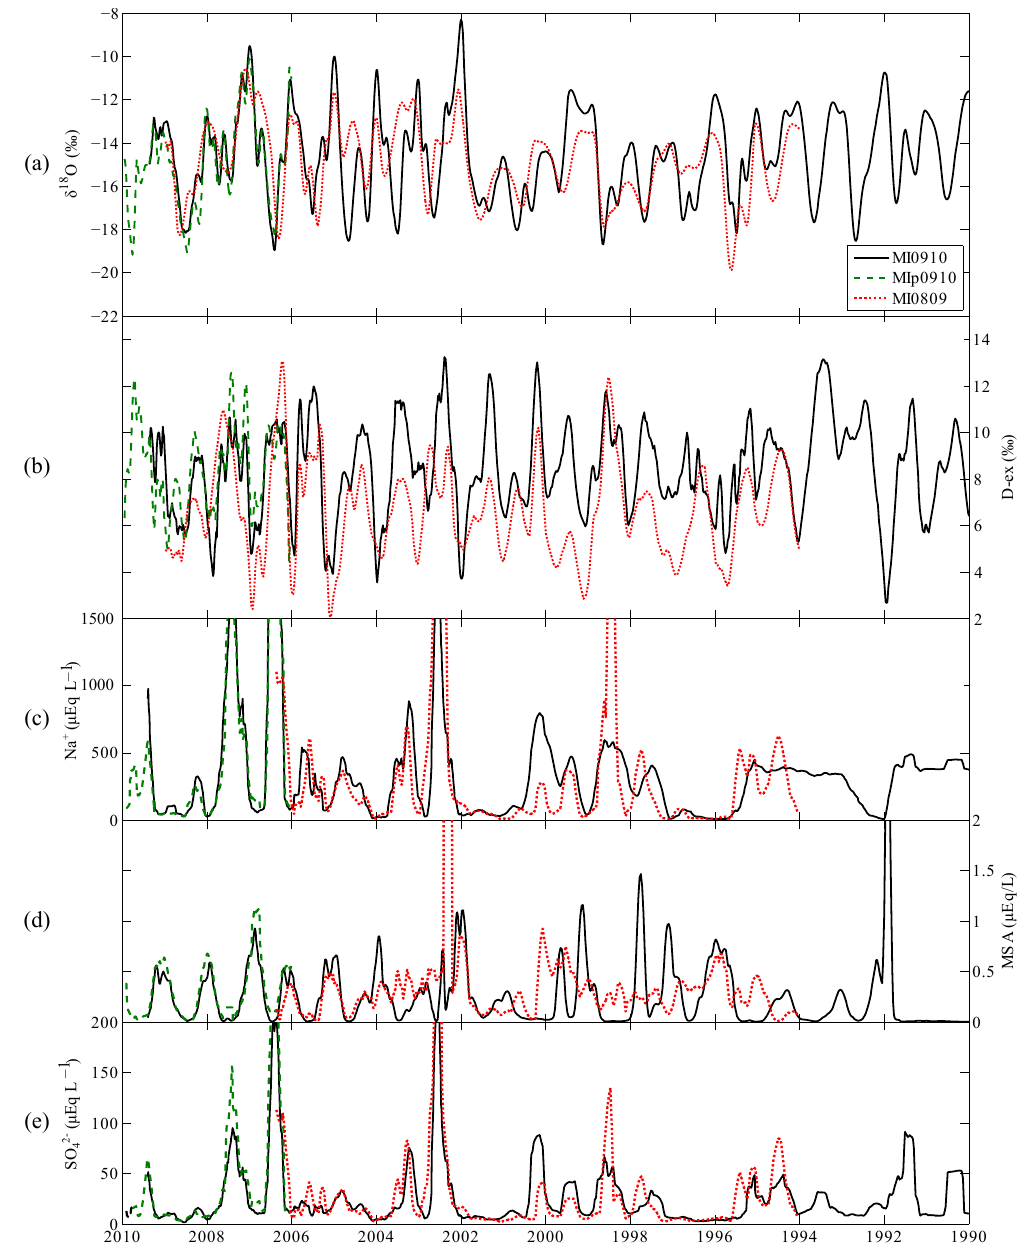
− records from MI0910 (black solid line), MIp0910 (green 4